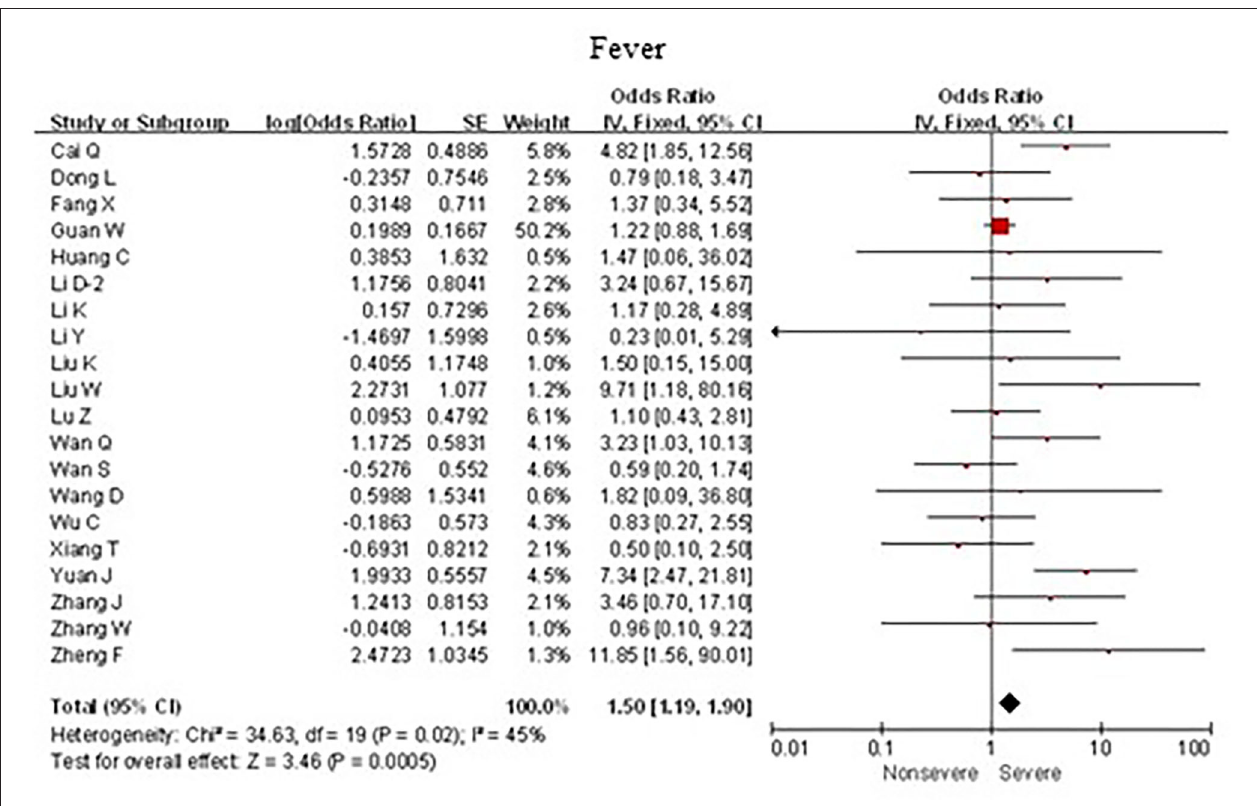
FIGURE 4 | Forest plots of odds ratios (ORs) showed the associations between fever and disease progression of COVID-19 pneumonia.